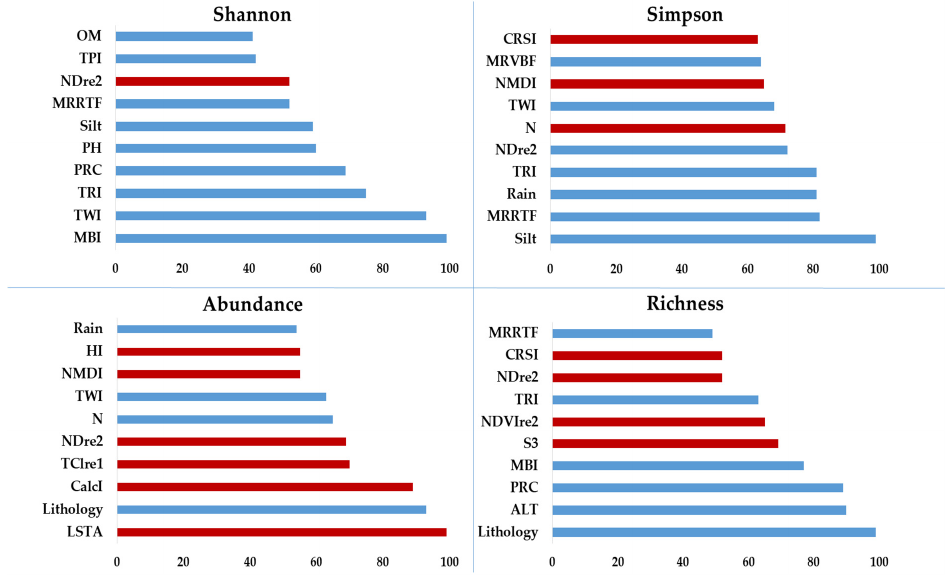
Figure 5. Ten of the most important variables in modeling and predicting the Simpson’s, Shannon’s, and richness’ indexes, as well as vegetation cover in April for RF models, based on remotely sensed and geodiversity variables . Remotely sensed variables are shown in red, and geodiversity variables are shown in blue.